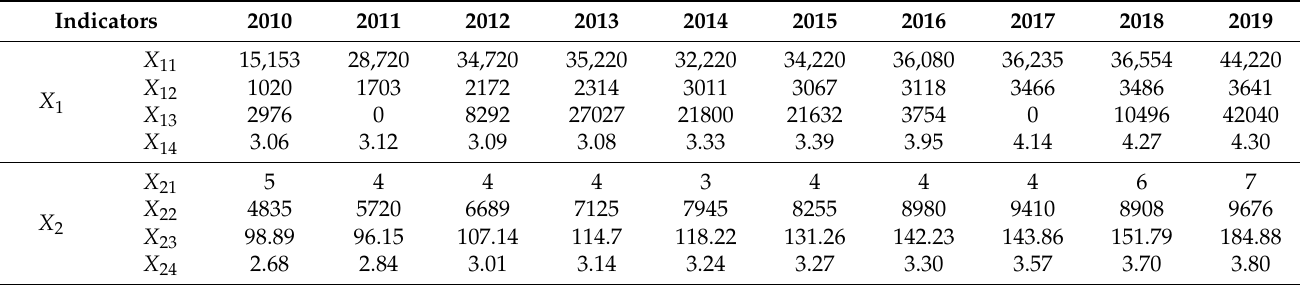
Table 1. Original integrated MSW management evaluation indicators